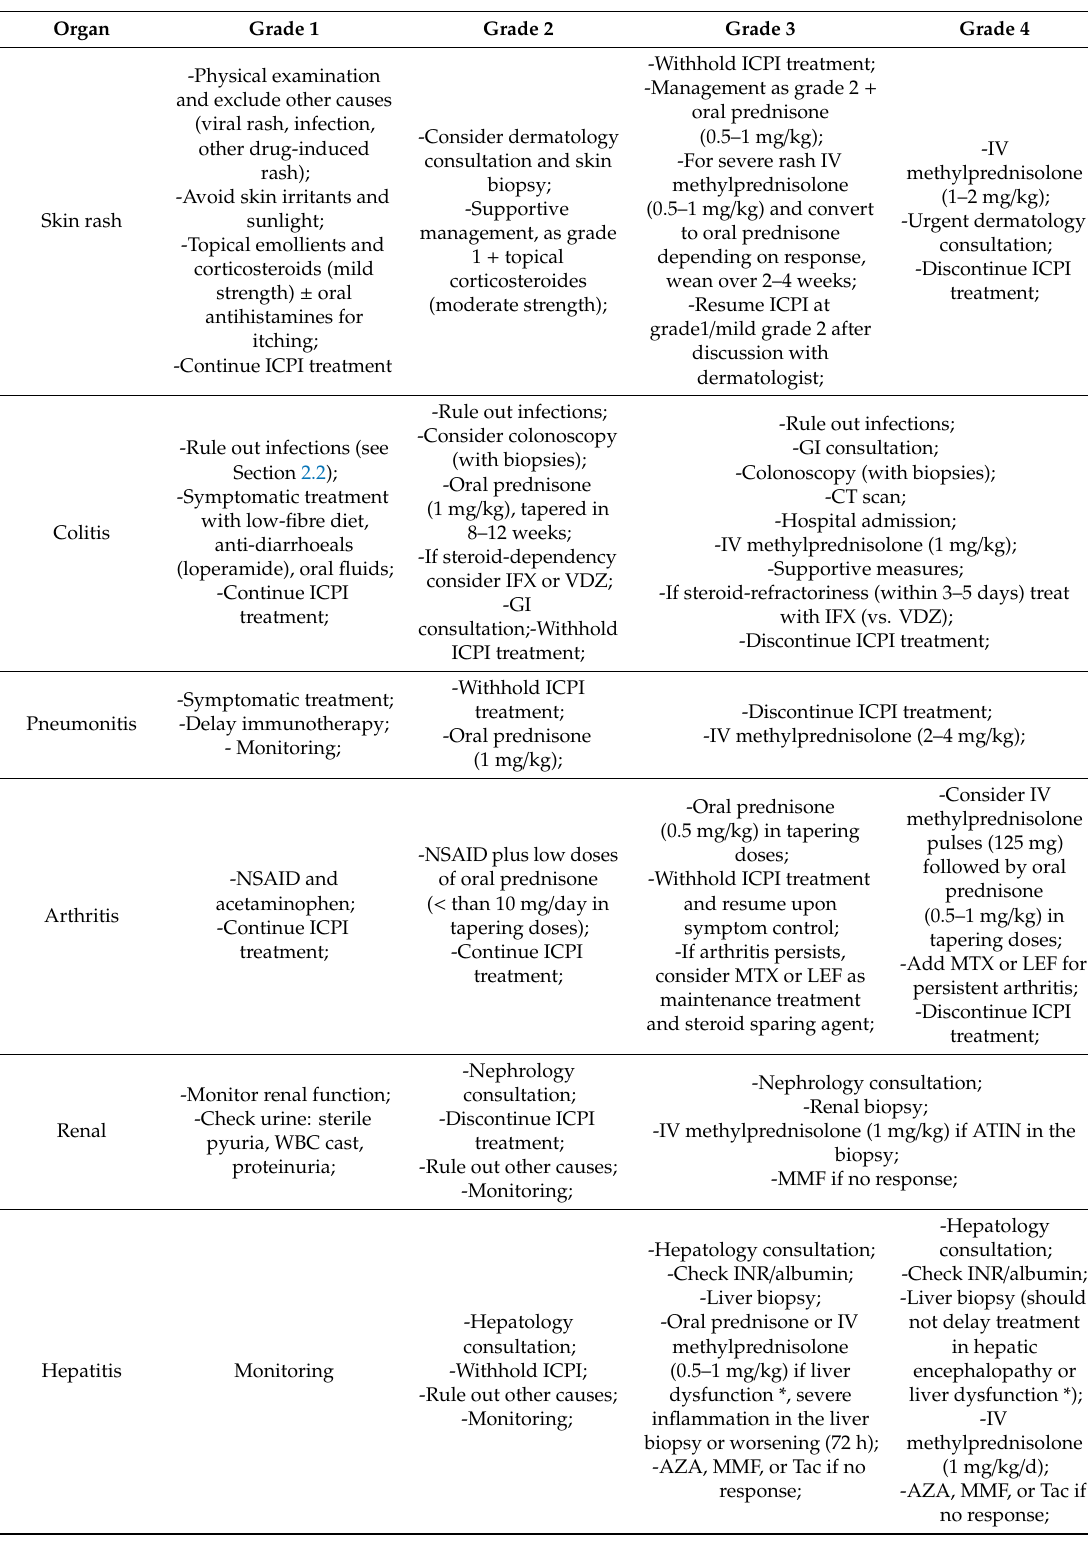
Table 1. Multidisciplinary approach to monitoring and treatment of immune-related adverse